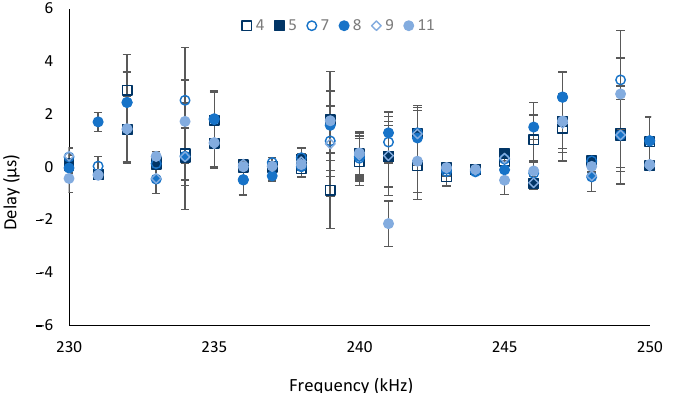
Figure 9. Vpp for the selected frequencies according to the temperature value. Data include the repetitions performed for the different pH values. Figure 10 represents the selected frequency range against the delay for the different pH values. It is observed that when the frequency values are higher and close to the working frequency, the delay values go from positive to negative values. As in Figure 11, the frequency is a function of the delay considering the temperature. No relationship with temperature is observed in this graph.